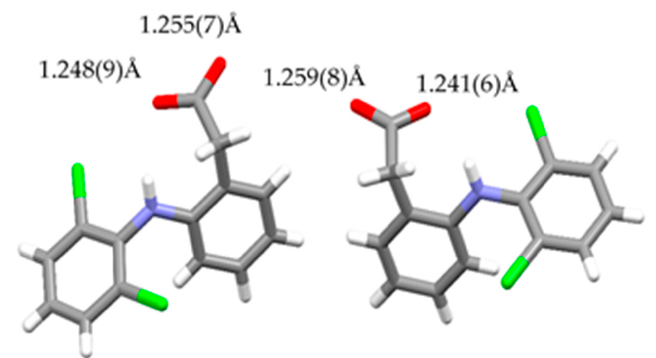
Figure 7. C–O distances in diclofenac molecules in NDPT.